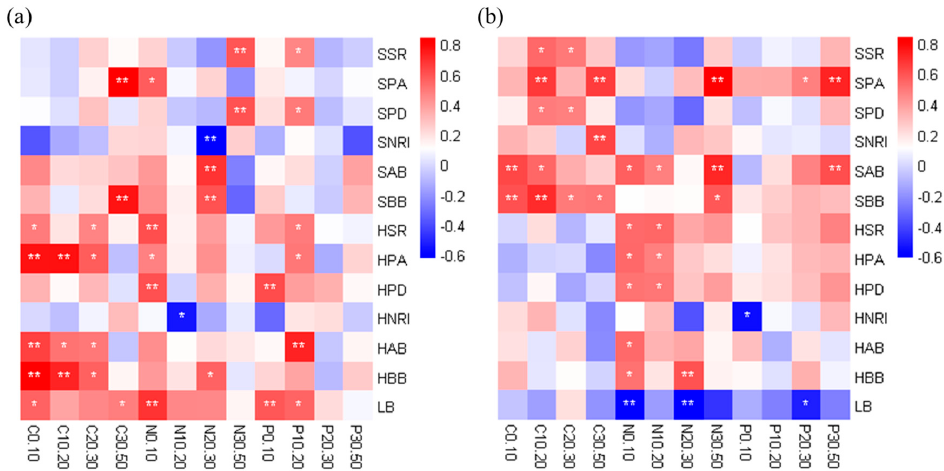
Figure 5. The variance component of soil nutrients explained by understory vegetation in the R. pseudoacacia forest ( a , b ) and P. tabuliformis forest ( c , d ). The overlap indicates a joint interpretation by the different groups.